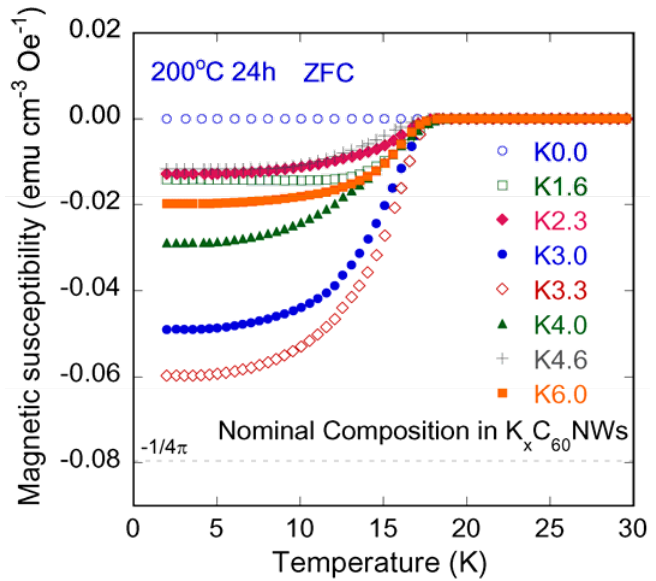
C NWs (x = 0.0–6.0). 3.3 60